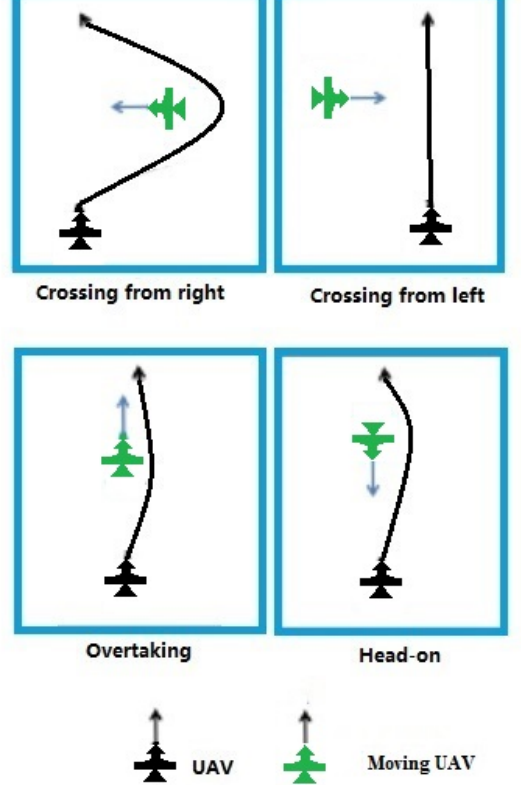
Figure 8. Rules of the sea, COLREGS. The rule is essentially about passing on the right side of other